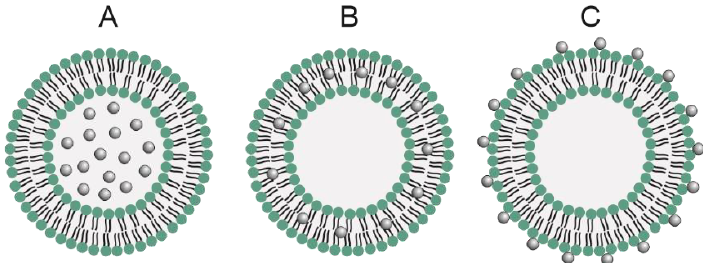
Figure 4. Illustration of magnetoliposomes with magnetic nanoparticles in ( A ): the aqueous lumen of the liposome, ( B ): on the lipid bilayer membrane, and ( C ) : bonded to the liposome’s surface